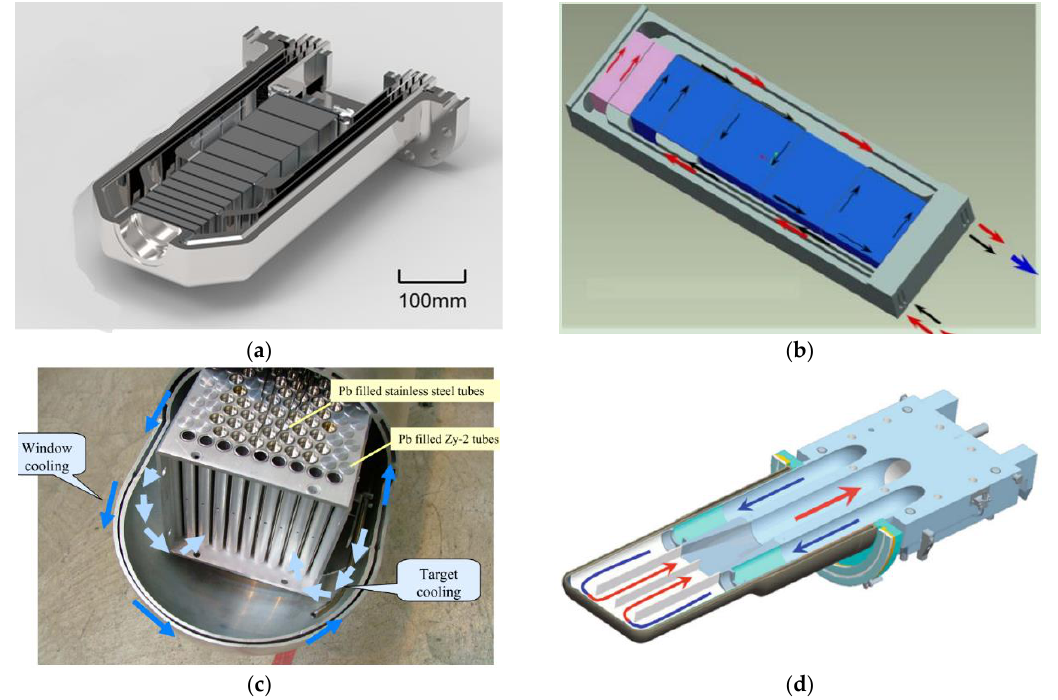
Figure 1. Different types of Spallation Neutron Target: ( a ) Spallation Neutron Target of ISIS; ( b ) Spallation Neutron Target of CSNS; ( c ) Spallation Neutron Target of PSI; ( d ) Spallation Neutron Target of SNS.